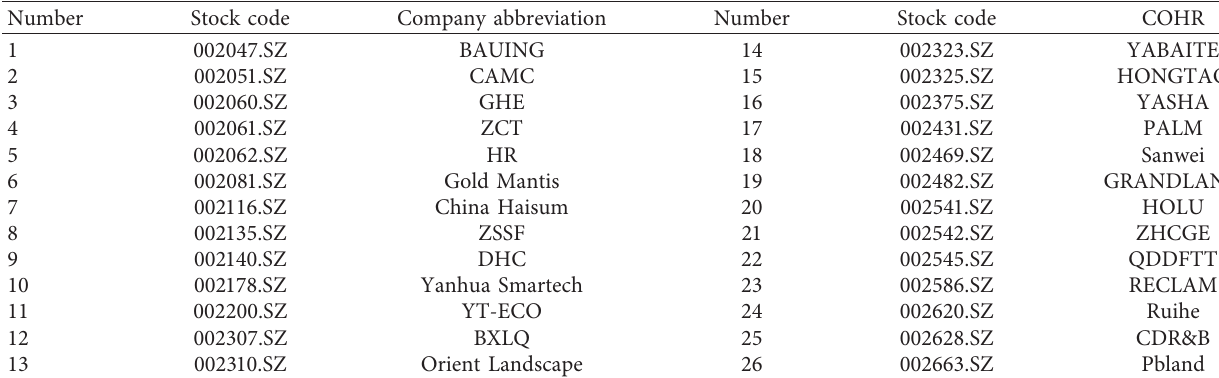
Table 2: The sample